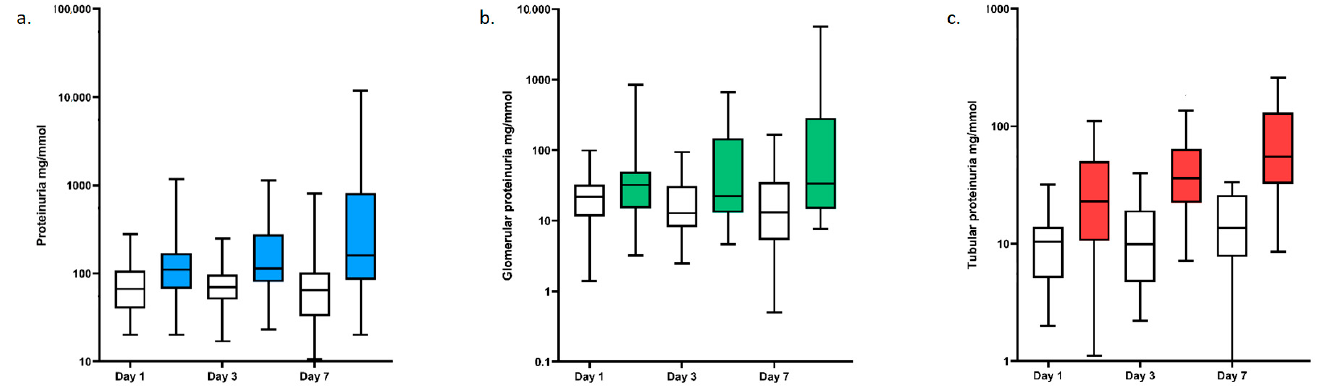
Figure 1. Boxplot of urine protein profile of COVID-19 critically ill patients on days 1, 3, and 7. ( a ) total proteinuria expressed as protein/creatinine ratios (median [IQR], min–max); white boxes: no-AKI patients; blue boxes: AKI patients; ( b ) glomerular proteinuria expressed as protein/creatinine